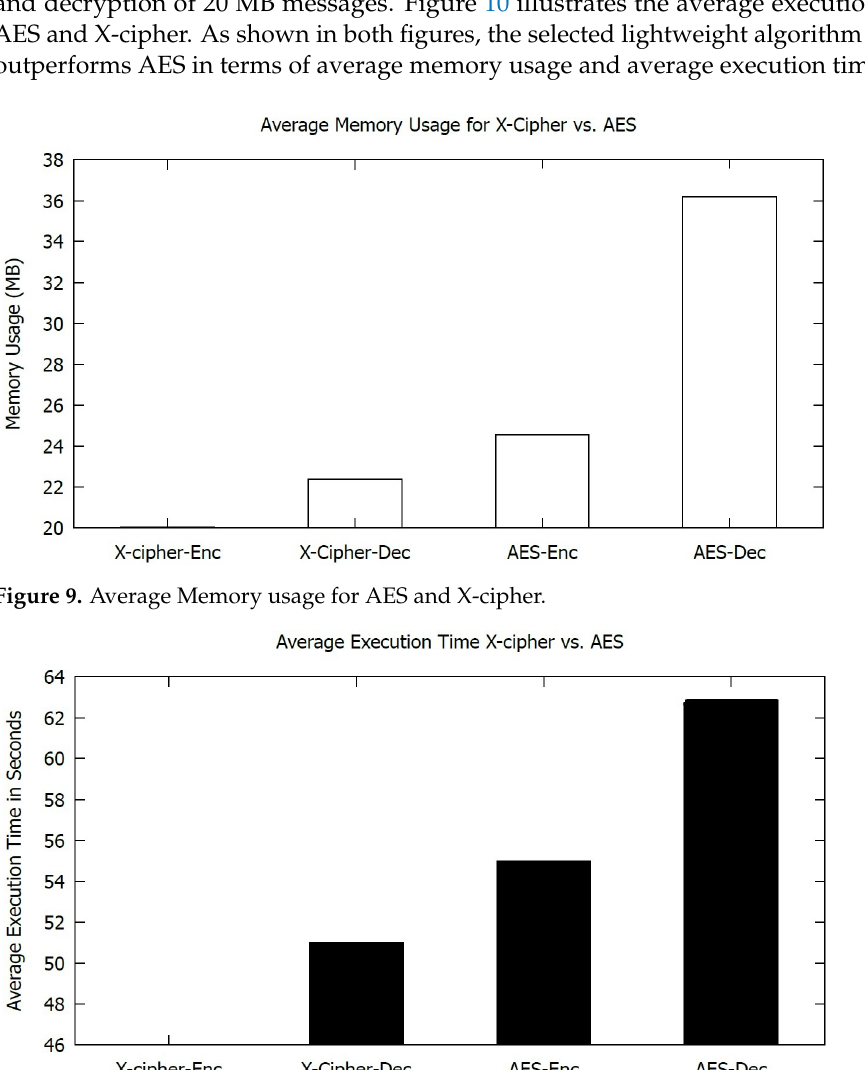
Figure 10. Average Execution time for AES and